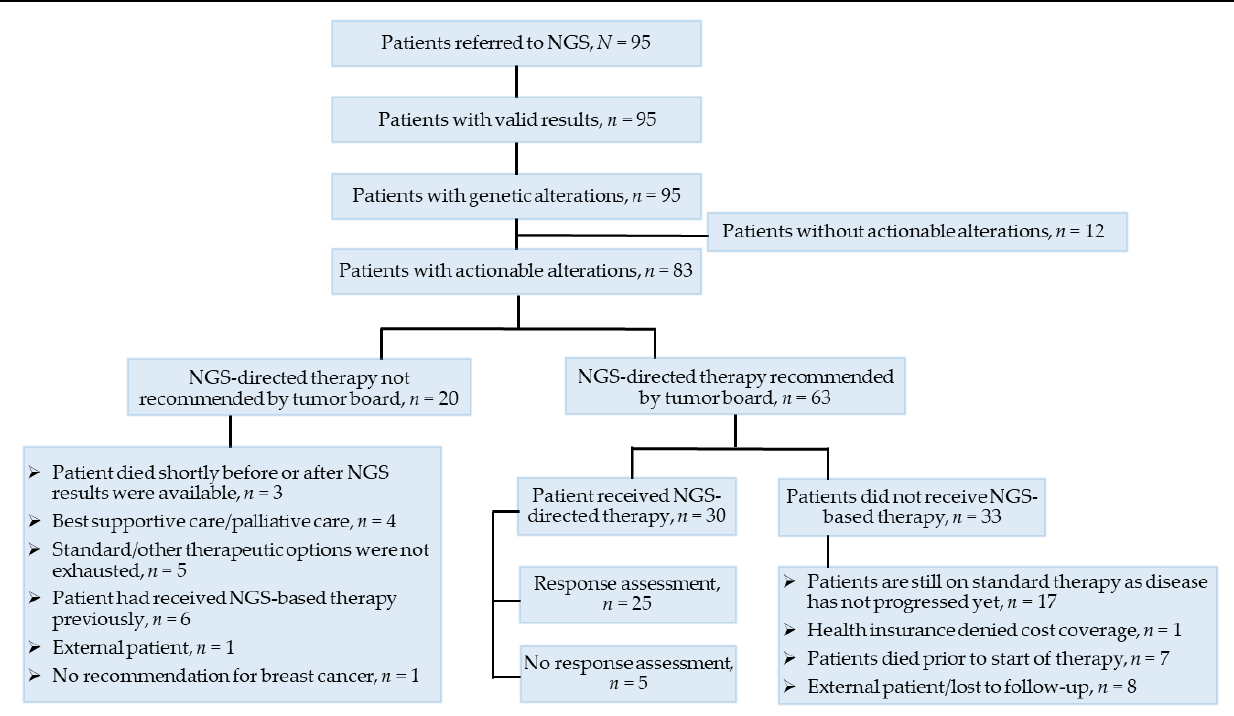
Figure 3. Patient flow of 95 patients who underwent molecular profiling with the FoundationOne ® (CDx) assay as part of their routine clinical practice. NGS, next-generation sequencing.